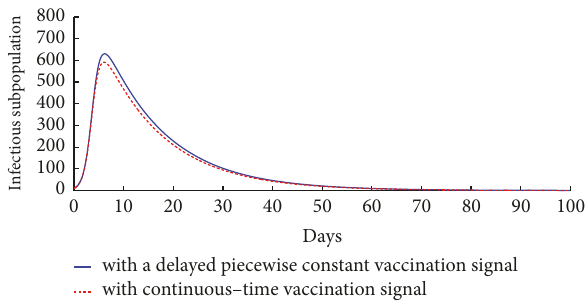
Figure 18: Infectious subpopulation in the SISV model with two different vaccination signals: (i) a delayed piecewise constant signal taking integer values and (ii) continuous-time signal.